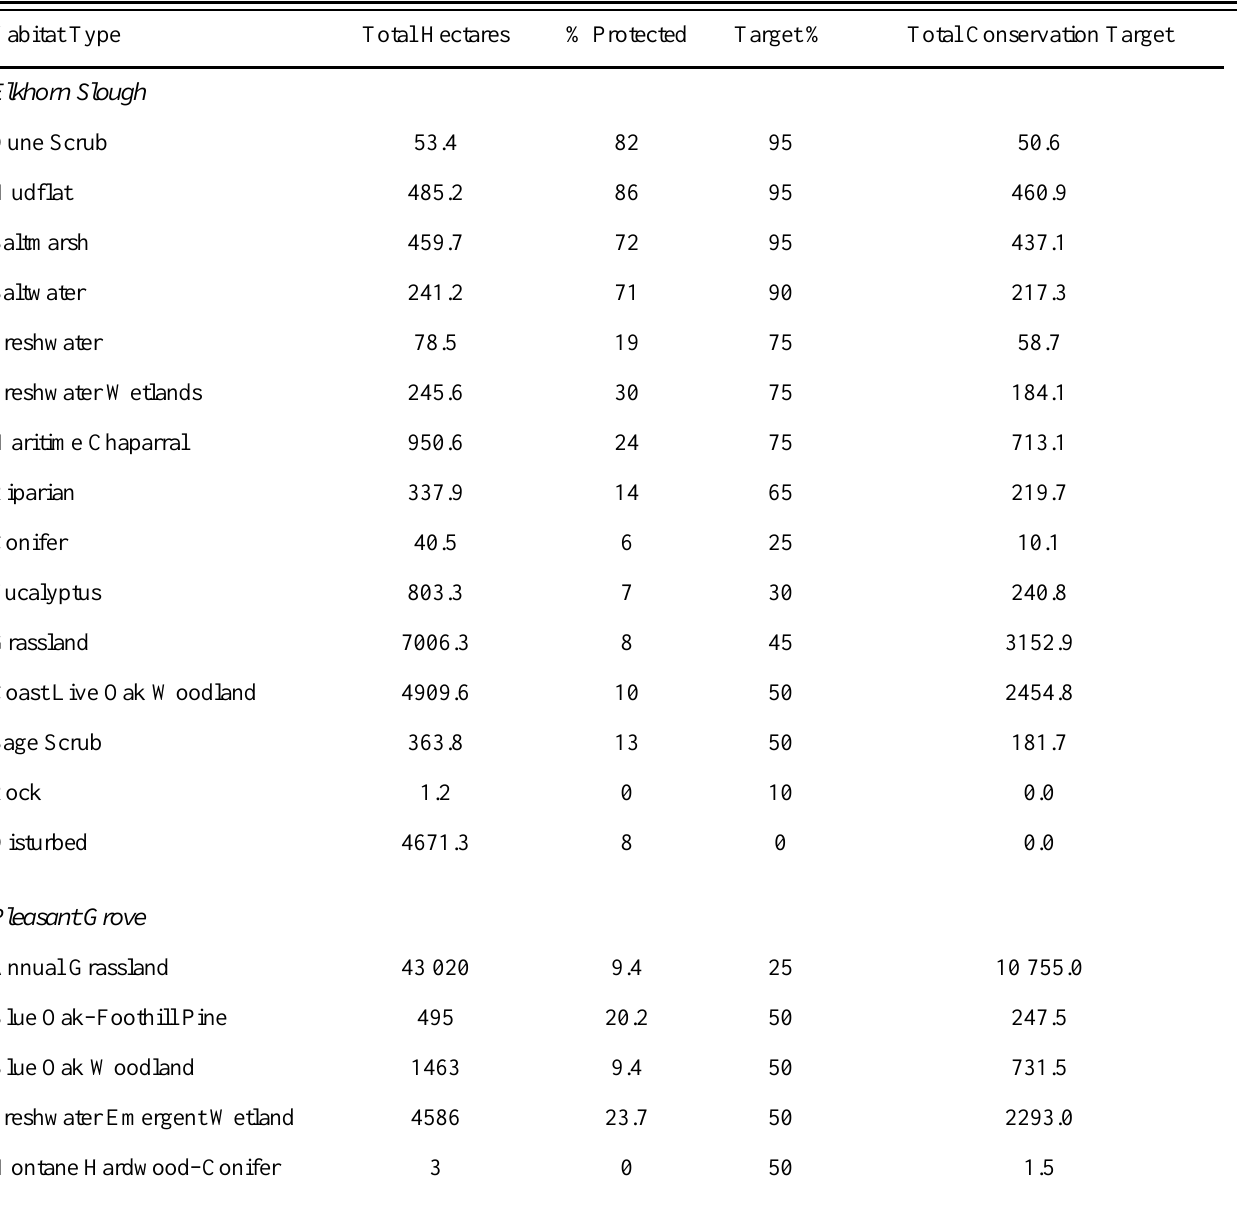
Table 2. Extent of dominant habitat types in each study area and the conservation objectives. For Elkhorn Slough, conservation objectives were defined by the Elkhorn Slough Foundation. Identified habitat extents were then used in the MARXAN run to identify the regional conservation design. For Pleasant Grove, we defined the habitat conservation targets. The target conservation amount for annual grasslands equals the middle of the three percentages shown. In the Pleasant Grove study, these conservation target levels were used in one of two MARXAN runs that defined the suitability of ownership parcels for the regional conservation design. The highest parcel value derived either from the MARXAN runs or the connectivity modeling was then used in the regional conservation design. This design was then used as a boundary within which the mitigation needs exercise ranked the suitability of